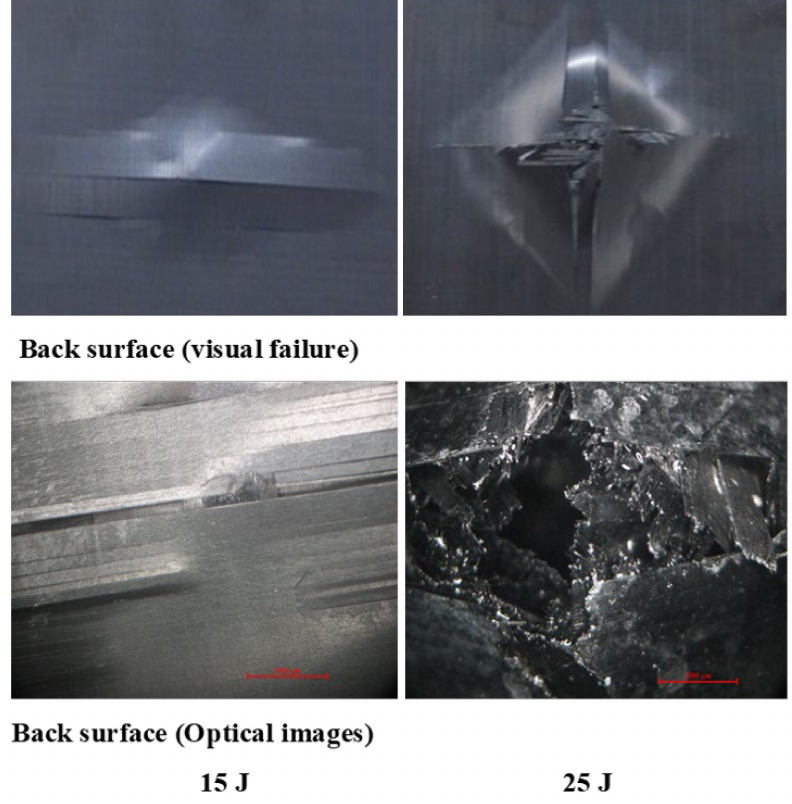
Figure 17. Pictures of the back surface failure view with visual and optical microscopy of [A/A] at 15 and 25